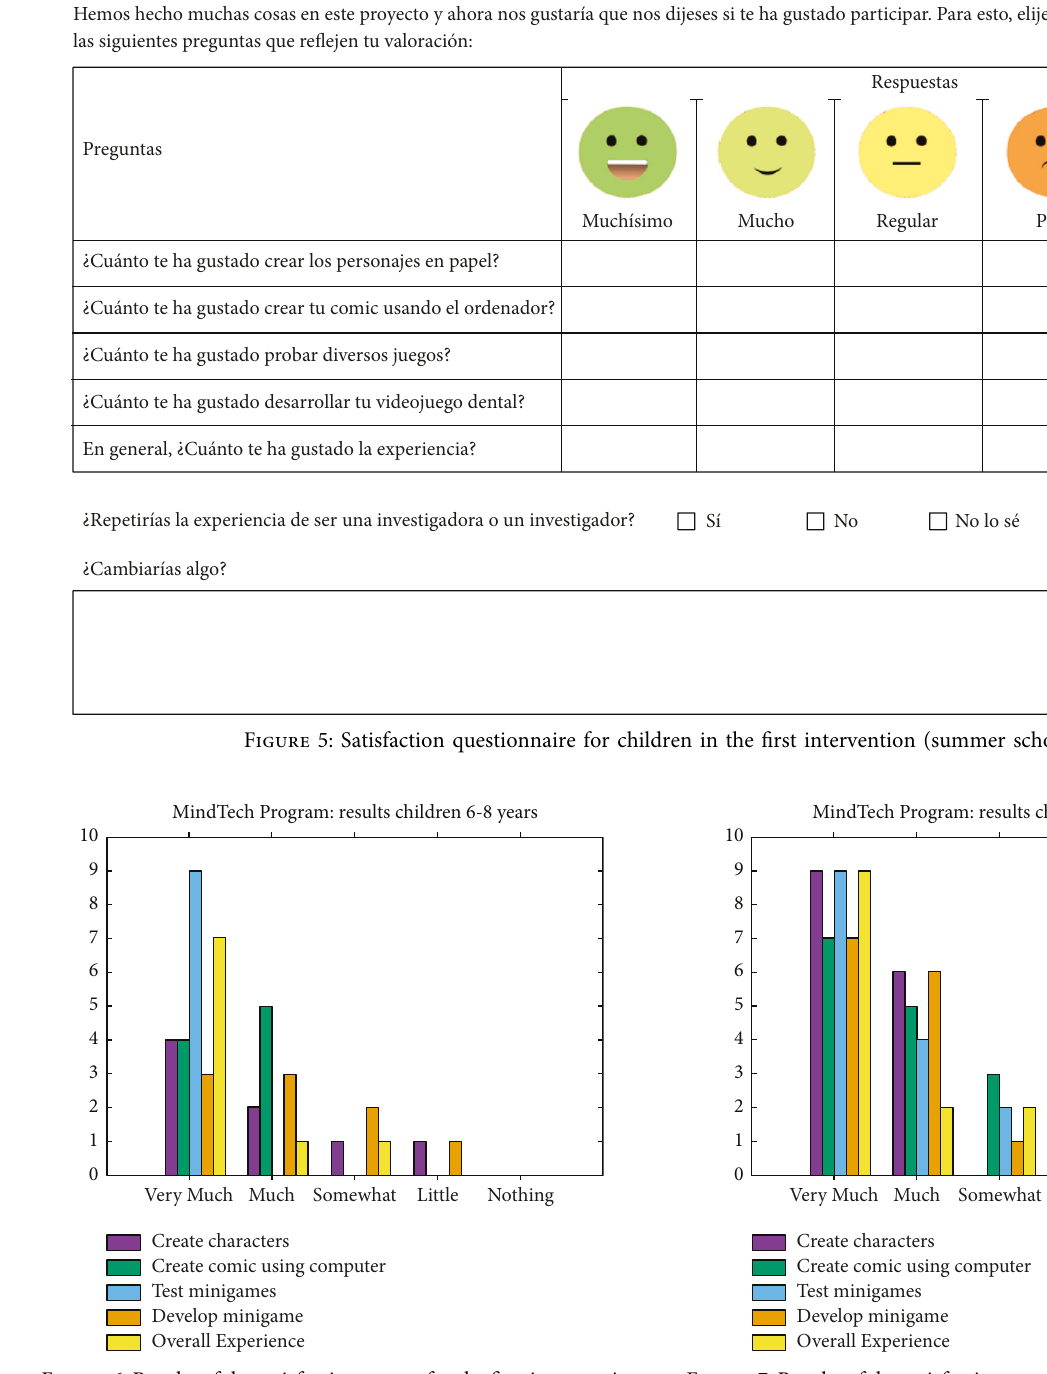
Figure 6: Results of the satisfaction survey for the first intervention with children 6–8 years of age (summer school).